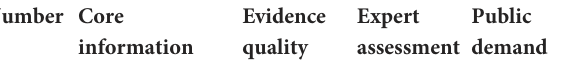
TABLE 6 The correlation between smoking and risks of female cardiovascular disease.